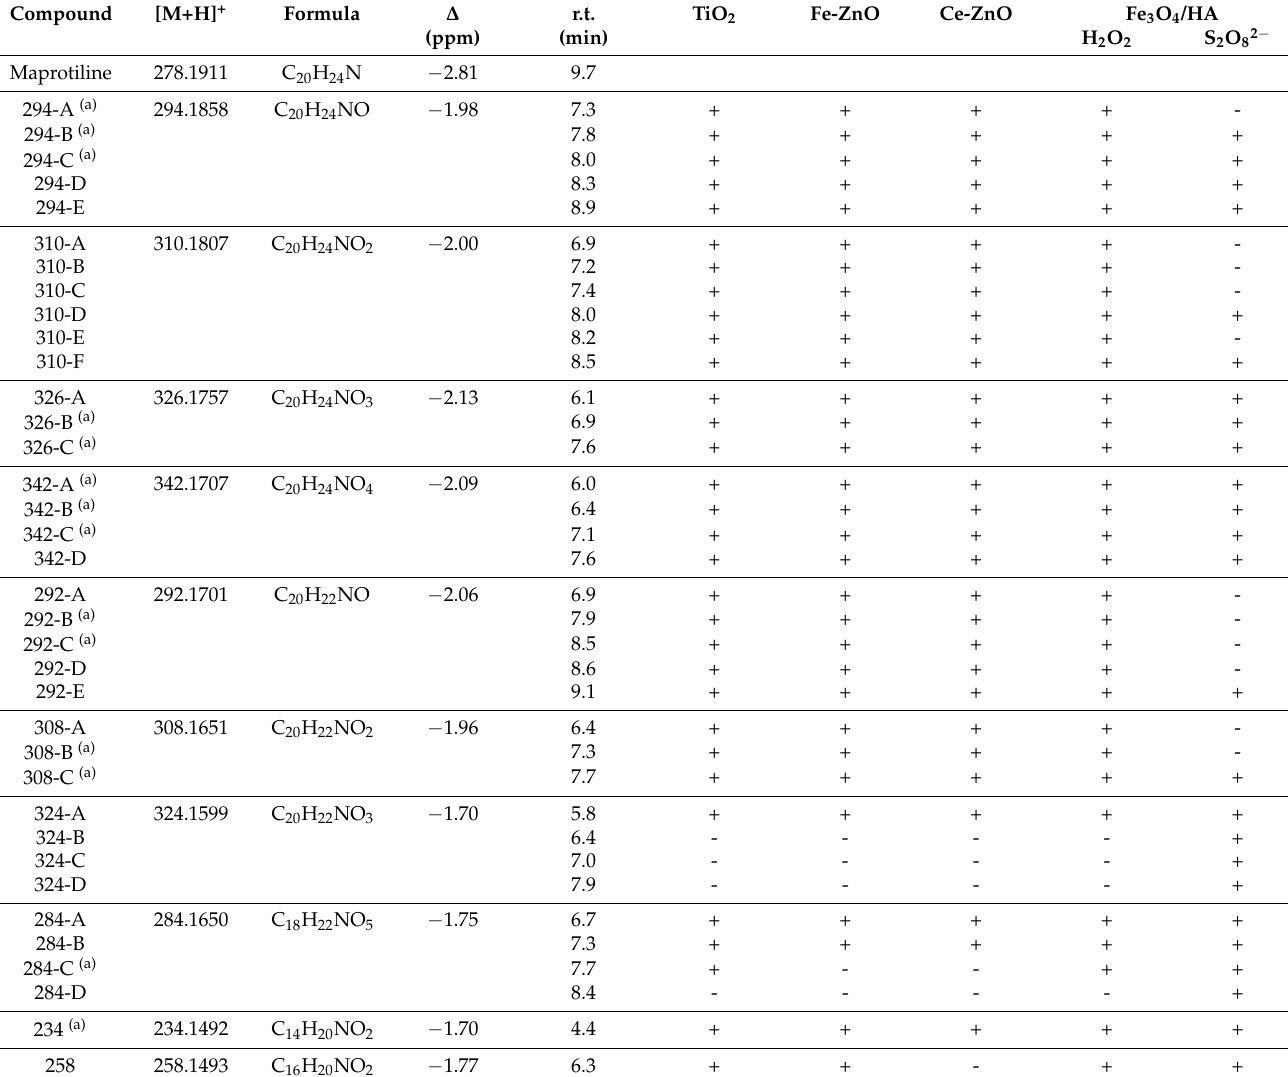
as presented in Table 1. The species identified were named based on their M+H + , e.g., 294-A corresponds to a isomer at m / z 294. mass In agreement with our previous studies [36], maprotiline degradation derives in several isomeric forms resulting from hydroxyl group addition(s) in several positions, namely mono- ( m / z 294), di- ( m / z 310), tri- ( m / z 326) and tetra-hydroxylated ( m / z 342) derivatives. From those, the corresponding dehydrogenated mono- ( m / z 292), di- ( m / z 308), and tri- hydroxylated ( m / z 324) species were also identified. Species resulting from the ring-opening were also observed ( m / z 284, 258, and 234). Table 1. Summary of TPs resulting from maprotiline degradation under different